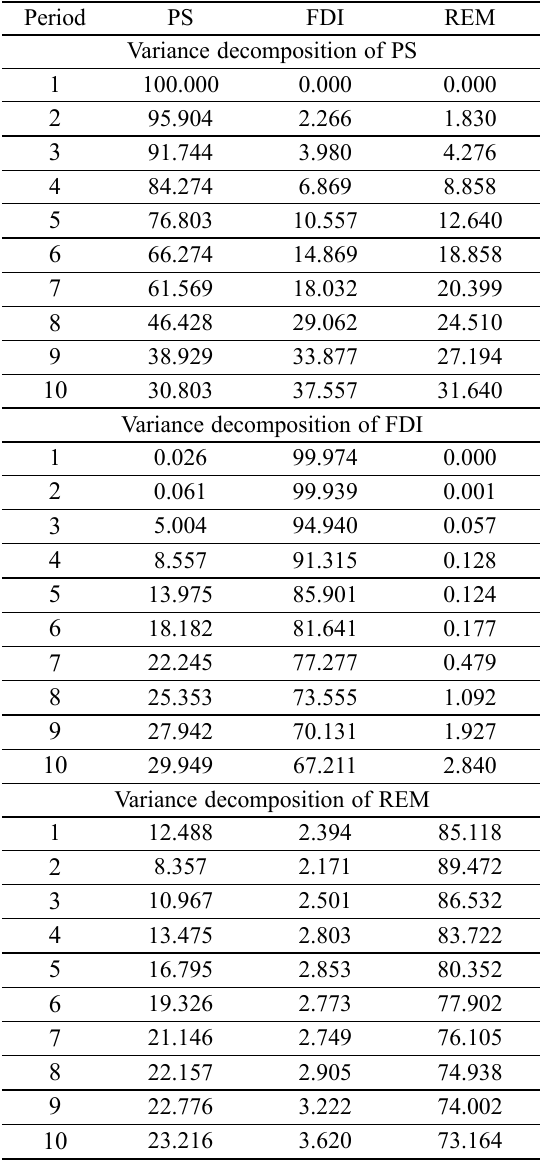
Table 9. Results of variance decomposition